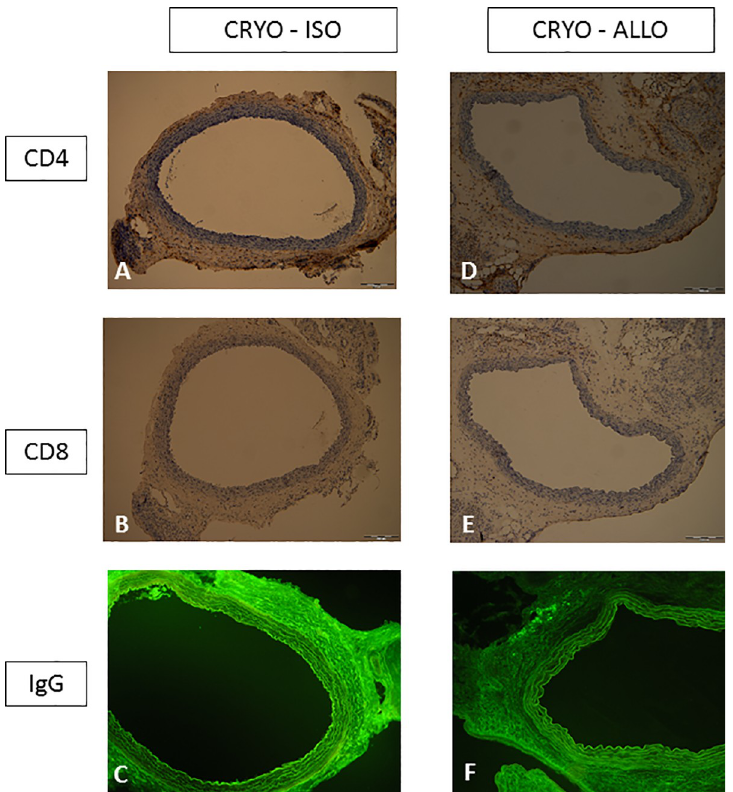
Fig 1. a,b,c,d,e,f. Representative light microscopic histological features of both isografts (a,b,c) and allografts (d,e,f) treated by our new cryoconservation/slow thawing protocol and obtained on day 30 following transplantation. Both isografts (Fig 1A, 1B, and 1C) and allografts (Fig 1D, 1E and 1F) showed clear differentiation of all three basic anatomical layers with no signs of intimal hyperplasia. No signs of medial layer destruction with immunoglobulins G deposition was detected in either isografts (Fig 1C) or allografts (Fig 1F). The adventitial infiltration of cryopreserved allografts by CD4+ (Fig 1D) and CD8+ cells (Fig 1E) (stained brown) was significantly higher compared to isografts (Fig 1A and 1B). Fig 1A and 1D –Anti-CD4 antibody, original magnification x 100, positive cells stained brown. Fig 1B and 1E –Anti-CD8 antibody, original magnification x 100, positive cells stained brown. Fig 1C and 1F –Anti-IgG fluorescein isothiocyanate-conjugated antibody, original magnification x